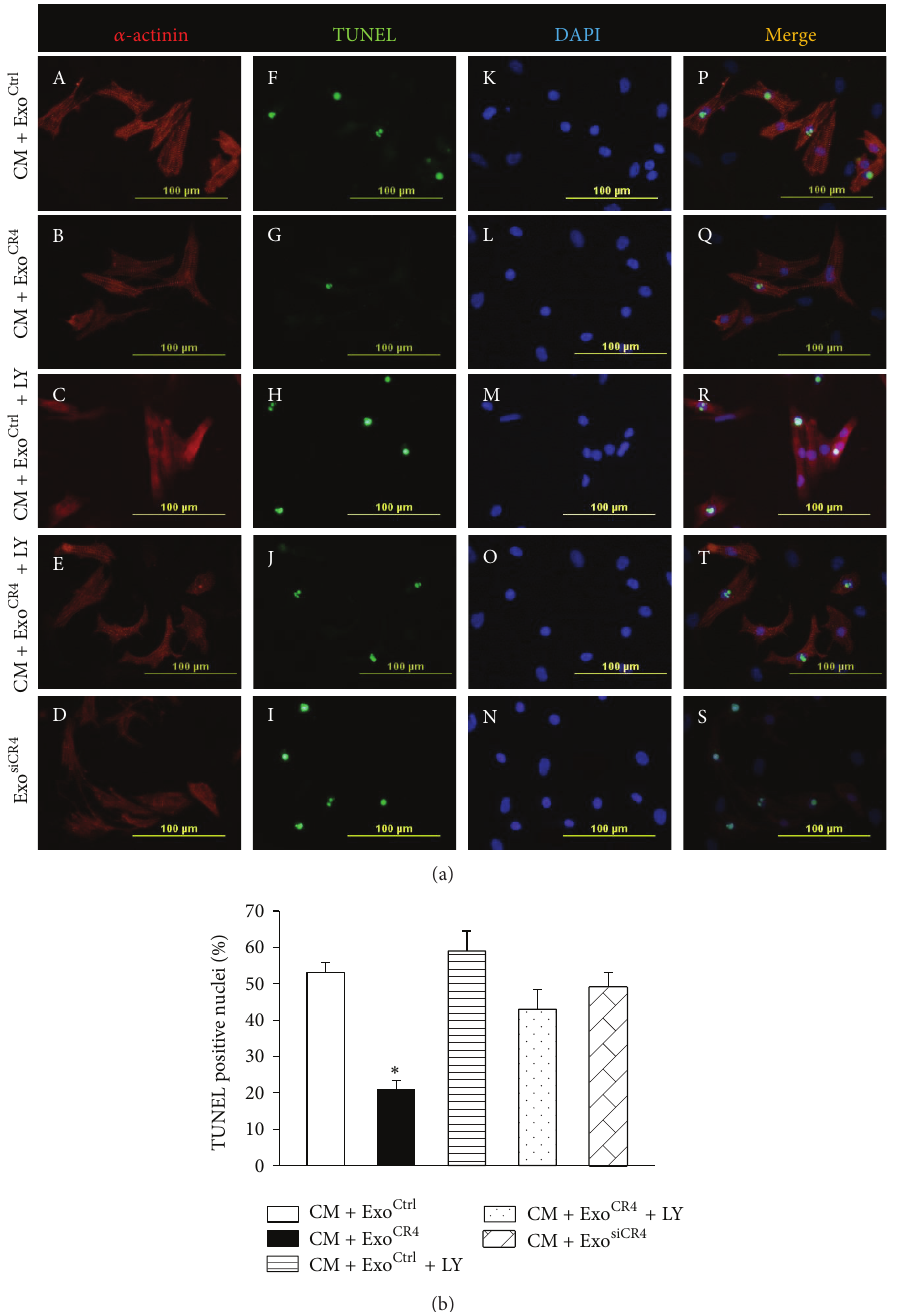
Figure 3: The effect of MSC CR 4 -derived exosomes on apoptosis. (a) TUNEL staining for CM apoptosis under hypoxic condition. CM labeled with cardiac specific antibody, sarcomeric 𝛼 -actinin (red). Nuclei were labeled with DAPI (blue) and TUNEL positive nuclei (green). Original magnification × 200. (b) Quantitative data for the numbers of TUNEL positive nuclei in various experimental groups. All values expressed as mean ± SEM. ∗ 𝑃 < 0.05 versus Exo Ctrl , 𝑛 = 6 for each group. CM + Exo Ctrl , CM treated with MSC Ctrl -derived exosomes; CM + Exo CR 4 , CM treated with MSC CR 4 -derived exosomes; CM + Exo Ctrl + LY, CM + Exo Ctrl -treated with LY294002 (a PI3K inhibitor); CM + Exo CR 4 + LY, CM + Exo CR 4 treated with LY294002; CM + Exo siCR 4 , CM treated with MSC siCR 4 -derived